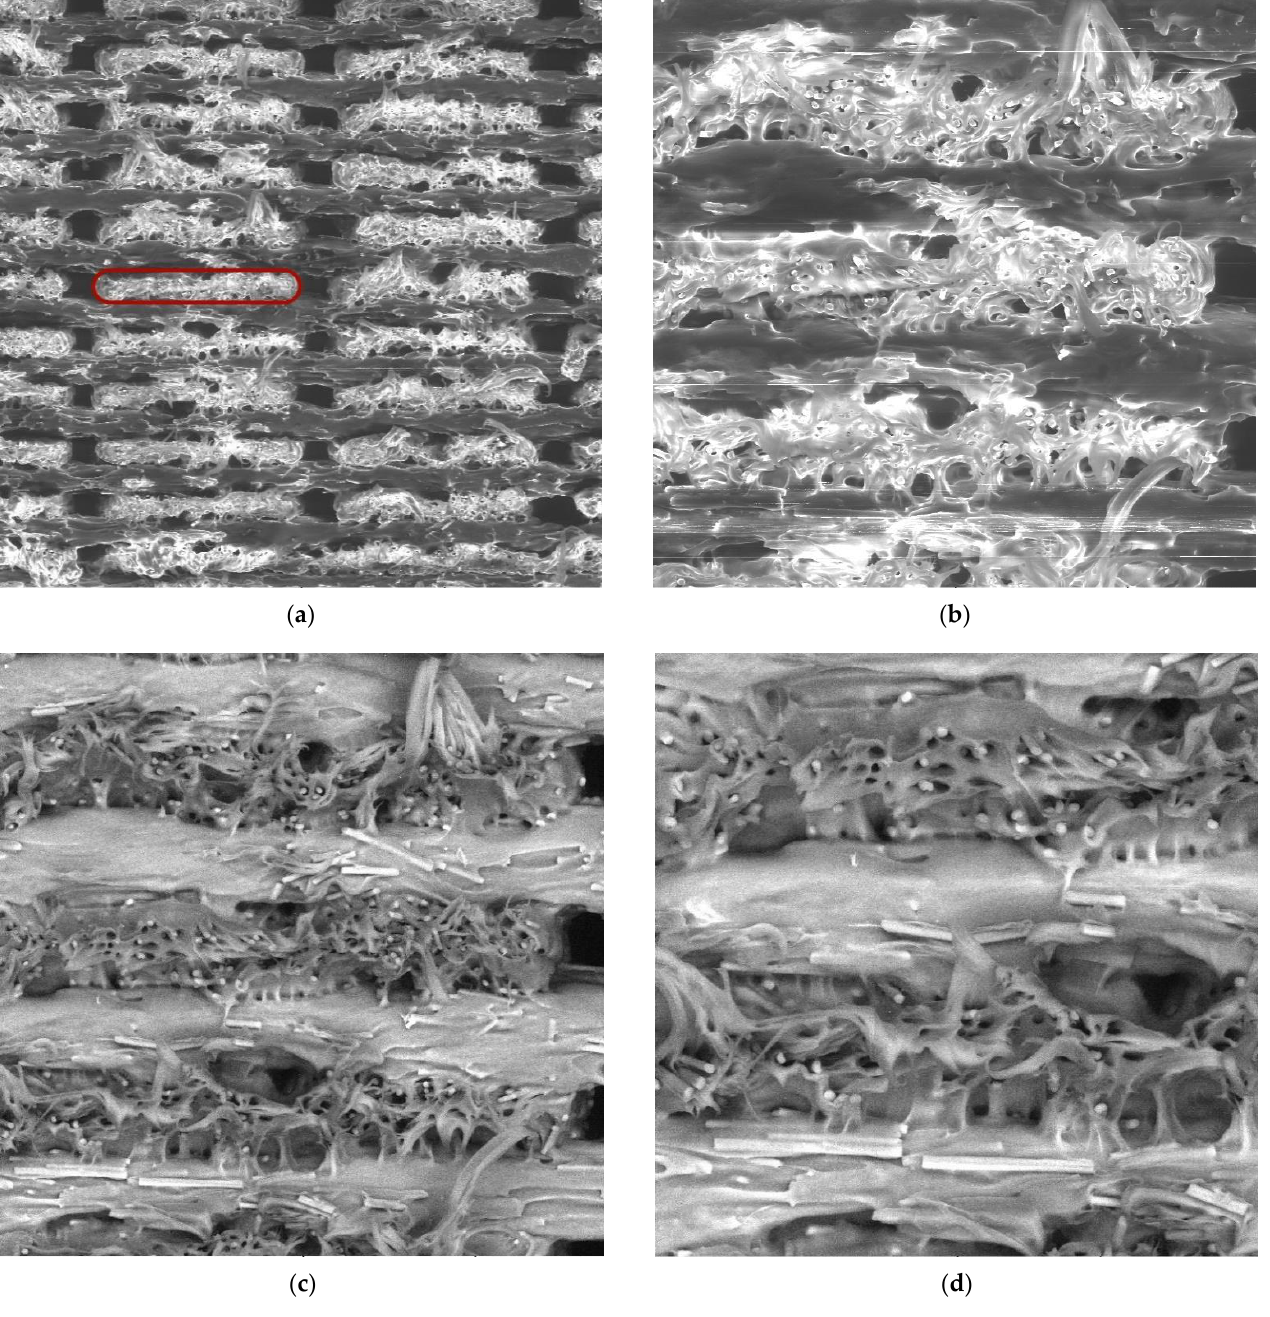
Figure 15 . SEM images of fractured specimen beta: ( a ) 100× magnification, detector LVSD, red box Figure 15. SEM images of fractured specimen beta: ( a ) 100 × magnification, detector LVSD, red box presents one filament; ( b ) 300× magnification, detector LVSD; ( c ) 300× magnification, detector BSE; presents one filament; ( b ) 300 × magnification, detector LVSD; ( c ) 300 × magnification, detector BSE; ( d ) 500× magnification, detector BSE. ( d ) 500 × magnification, detector